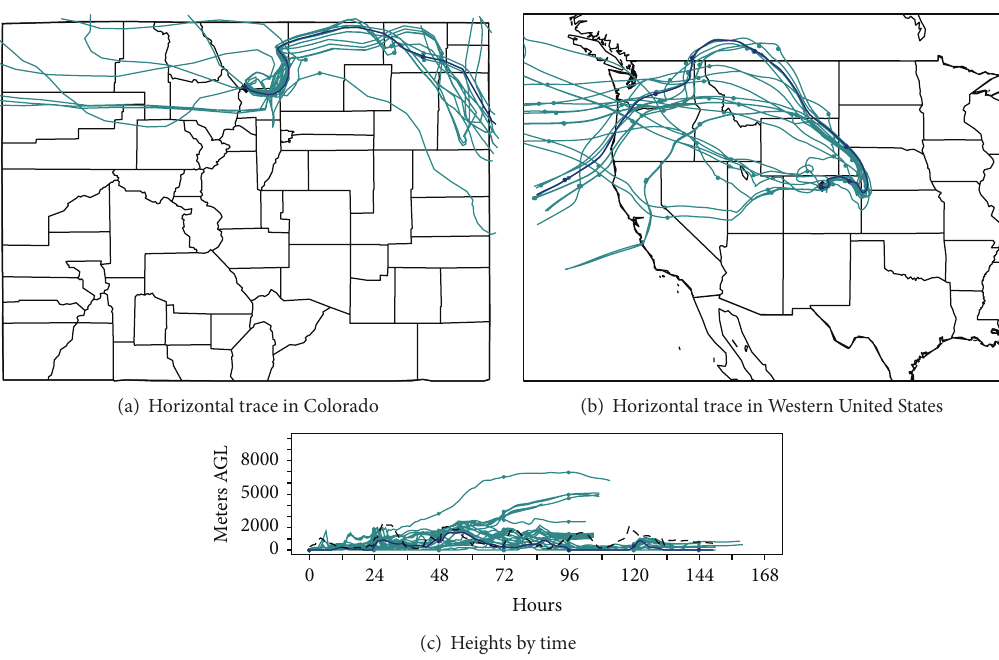
Figure 8: Hysplit ensemble back trajectories generated with WRF input for 10 May 2009, at 6: 00 pm MST. The heaviest line is the trajectory started from the core site. The lighter lines are the remaining 26 ensemble members. In panel (c), the dashed line is the height of the top of the mixed layer for core site trajectory. There is a dot after each day on all panels. Colorado is approximately 610km across. On panel (a), the distance from the Pacific Coast on the west to the eastern edge of the map is approximately 3200